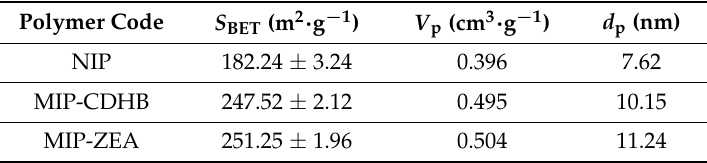
Table 9. Specific surface areas ( S BET ), total pore volumes ( V p ), and mean pore diameters ( d p ) for synthesized NIP and